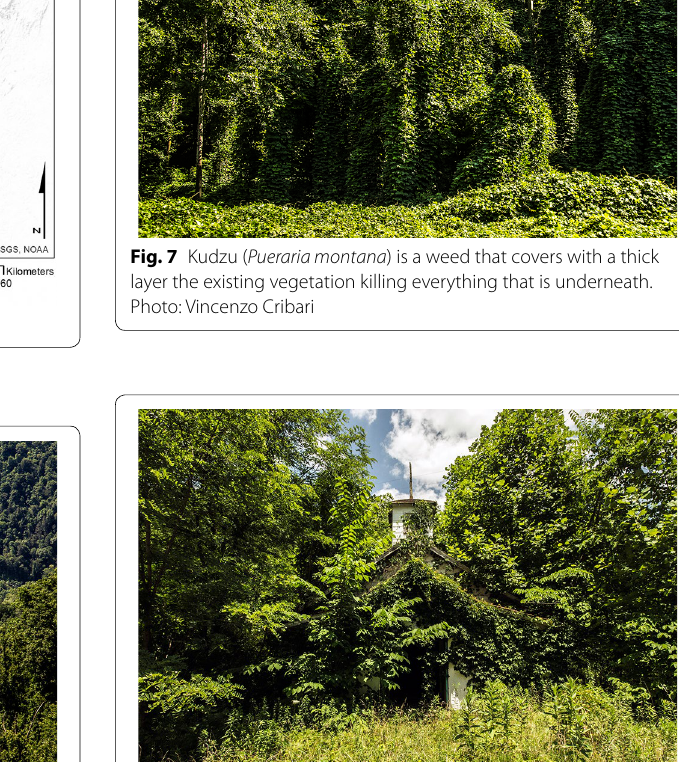
Fig. 8 An example of how vegetation colonizes abandoned buildings. Photo: Vincenzo